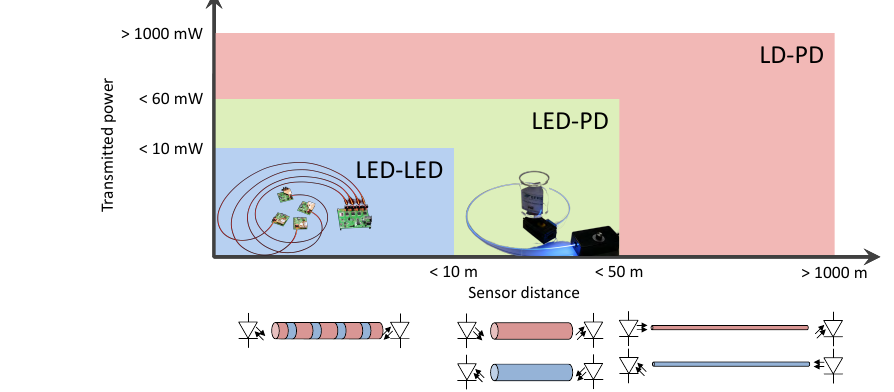
Figure 4. Application ranges for different optically powered sensor systems.